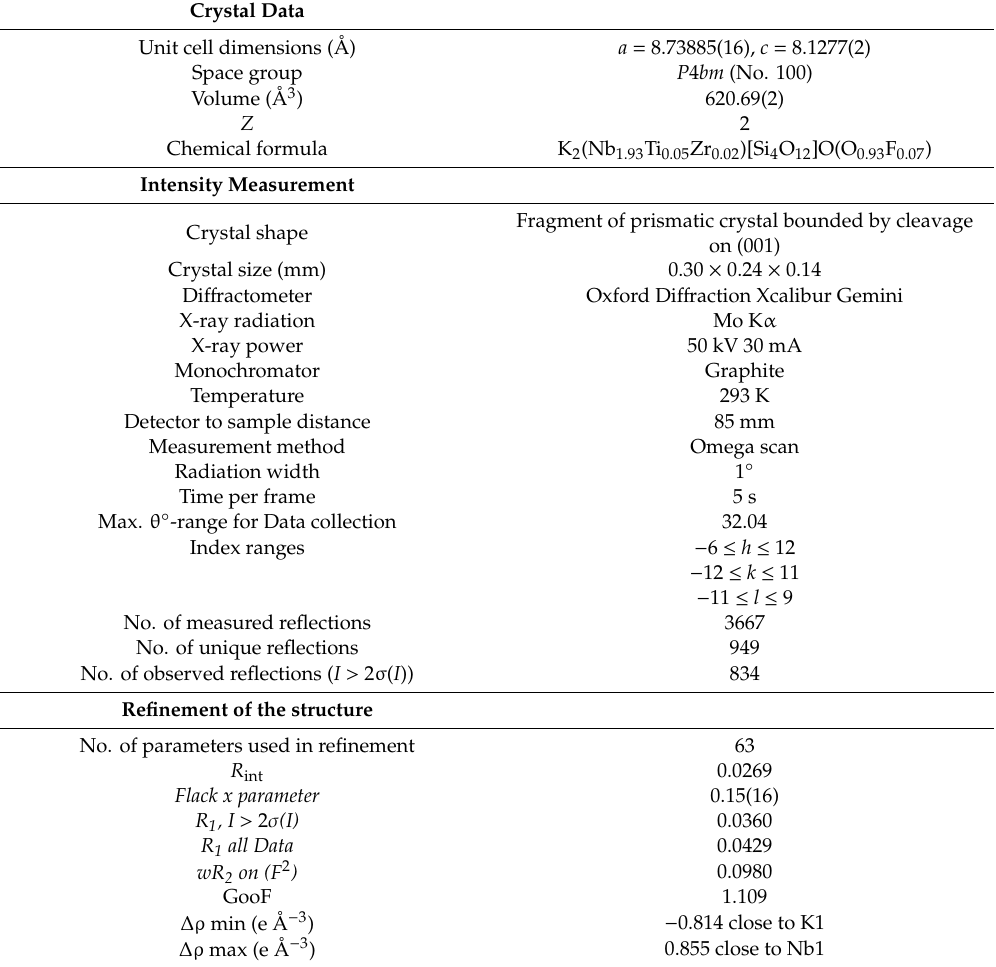
Table 6. Data collection and structure refinement details for rippite.